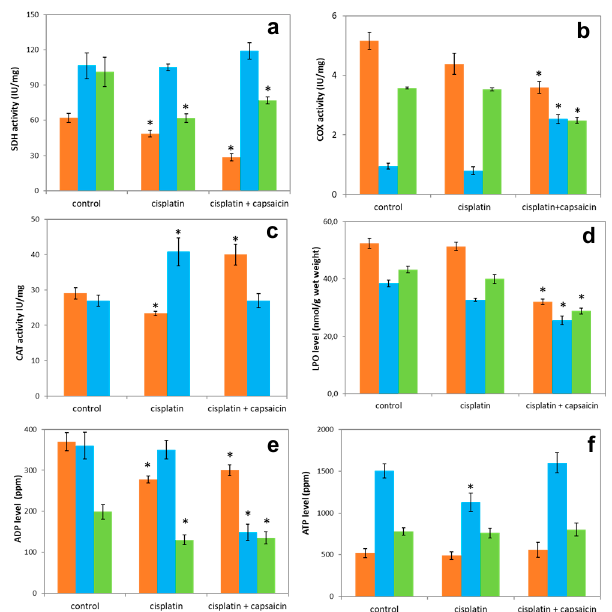
Figure 7. ( a ) SDH activity, ( b ) COX activity, ( c ) CAT activity, ( d ) LPO levels, ( e ) ATP levels, and ( f ) ADP levels in lung ( ⎯ ⎯ ), heart ( ⎯ ⎯ ), and brain ( ⎯ ⎯ ) tissues for the control and cisplatin groups for the 7 th day, and group with capsaicin exposure followed by 7 days of cisplatin injection. These results are expressed as mean ± SD ( n = 6). *Significantly different ( p < 0.05) from control.